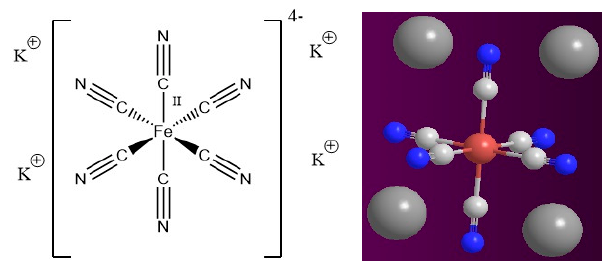
Figure 2. Chemical structure of PF.